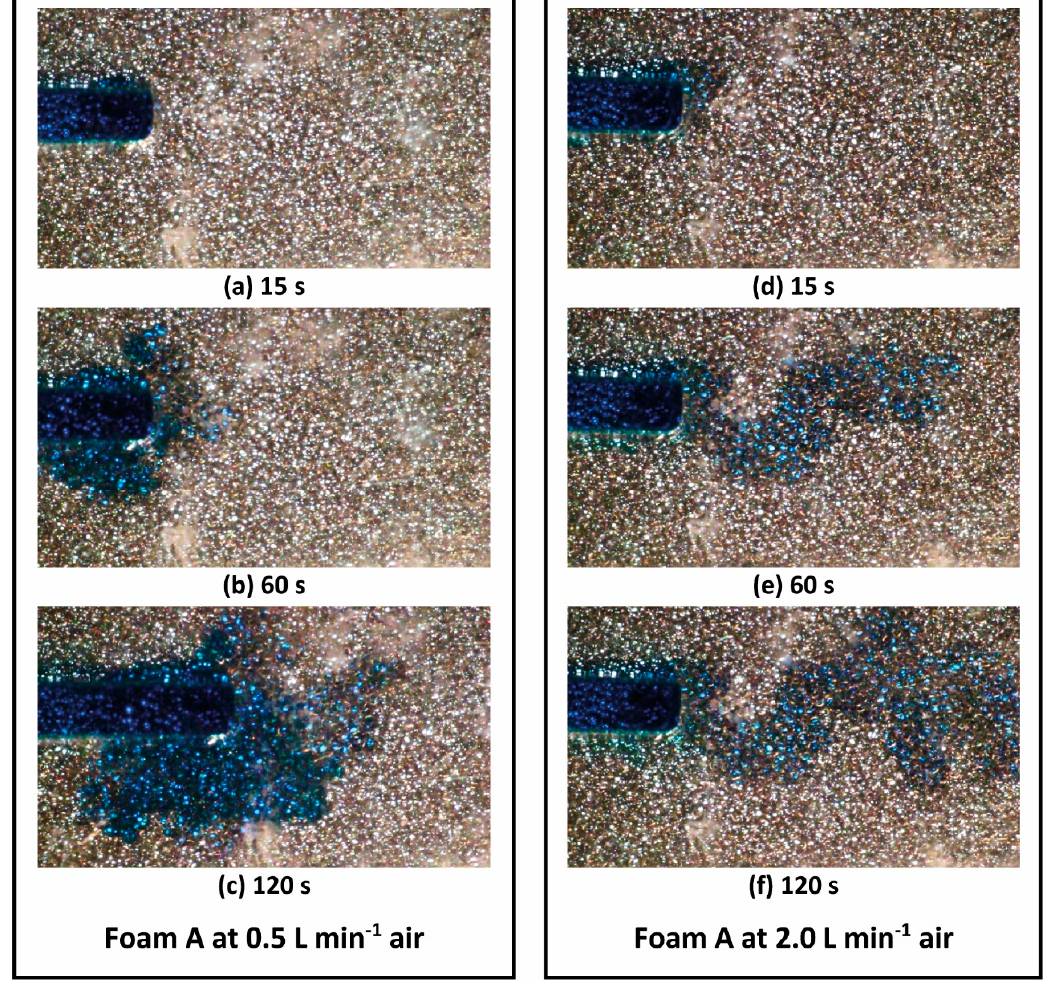
Figure 4. Propagation of liquid water in foam A (1.6 mm thick) air flow (left to right), 7.7 mm × 5.0 mm field of view. After ( a ) 15 s, ( b ) 60 s and ( c ) 120 s at 0.5 L min − 1 air flow and ( d ) 15 s, ( e ) 60 s and ( f ) 120 s at 2.0 L min − 1 air